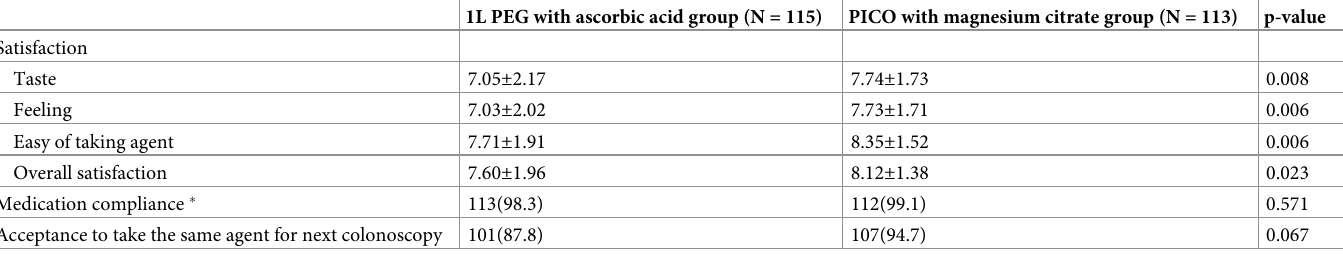
Table 3. Satisfaction and acceptability of the bowel cleansing